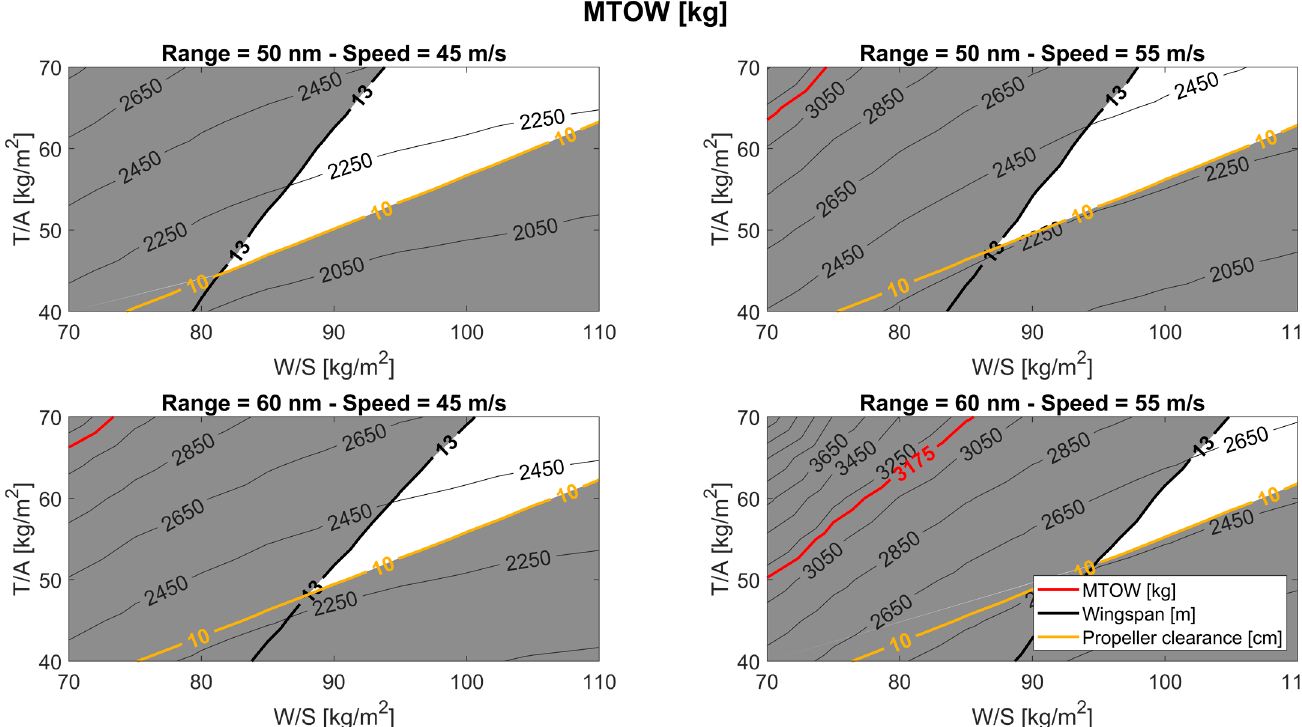
Figure 12. W/S vs. T/A charts of MTOW (current technology) varying speed and range. Each plot shows a highlighted area, which identifies the design space compliant with the constraints.